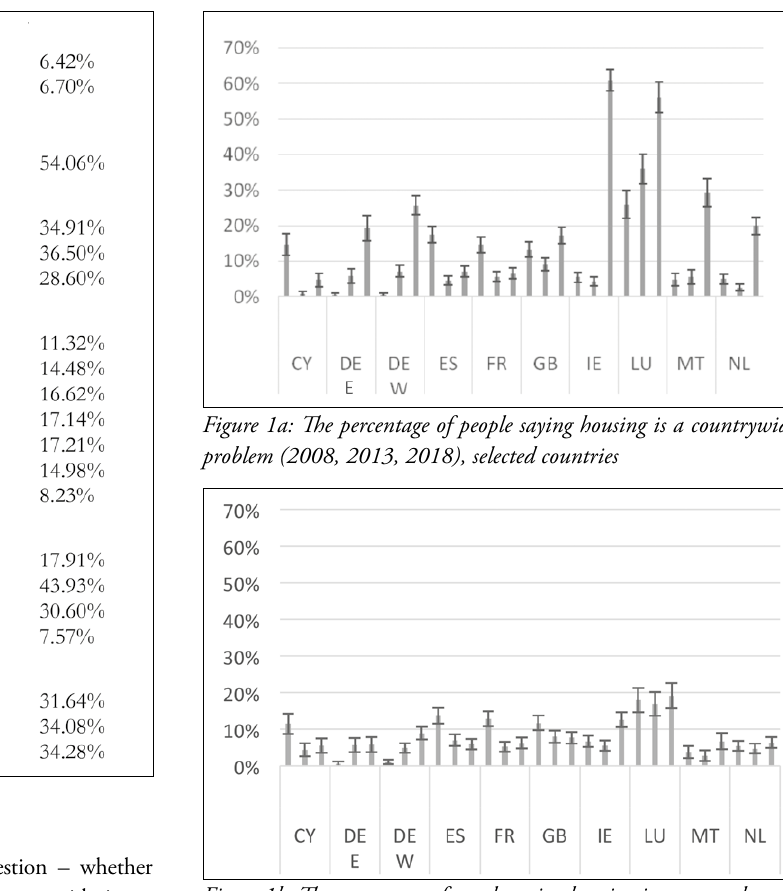
Figure 1b: The percentage of people saying housing is a personal prob- lem (2008, 2013, 2018), selected countries